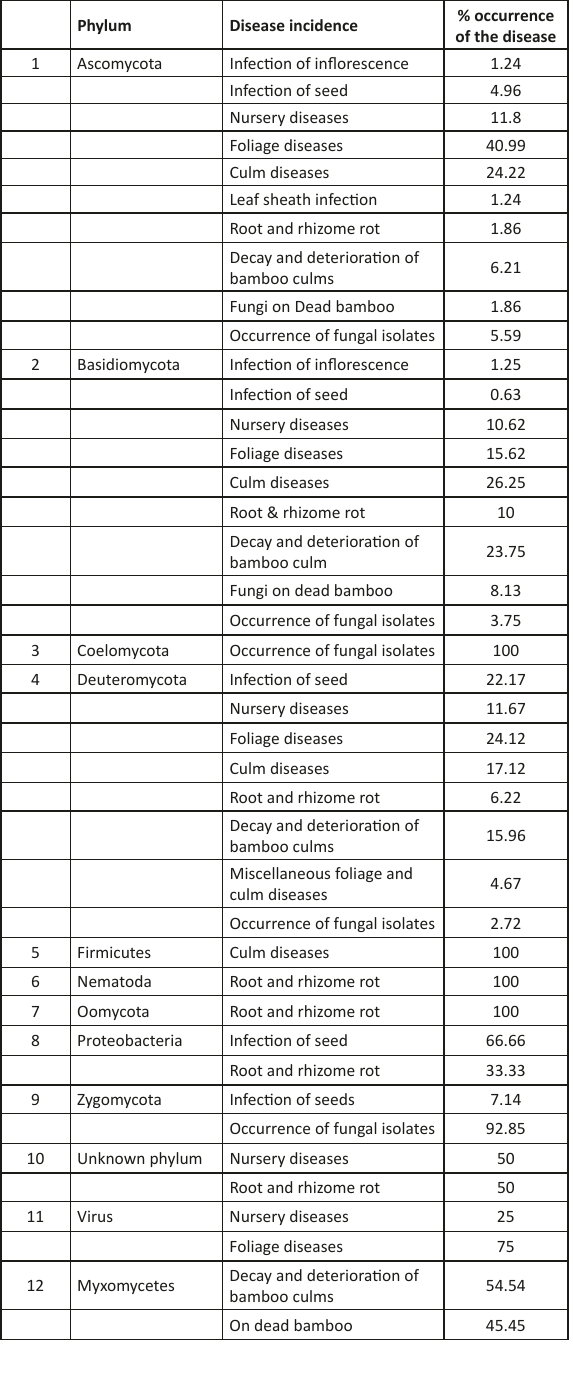
Table 2. Percentage incidence of the diseases in the different phyla Table 3. Percentage occurrence of the pathogens in different phyla